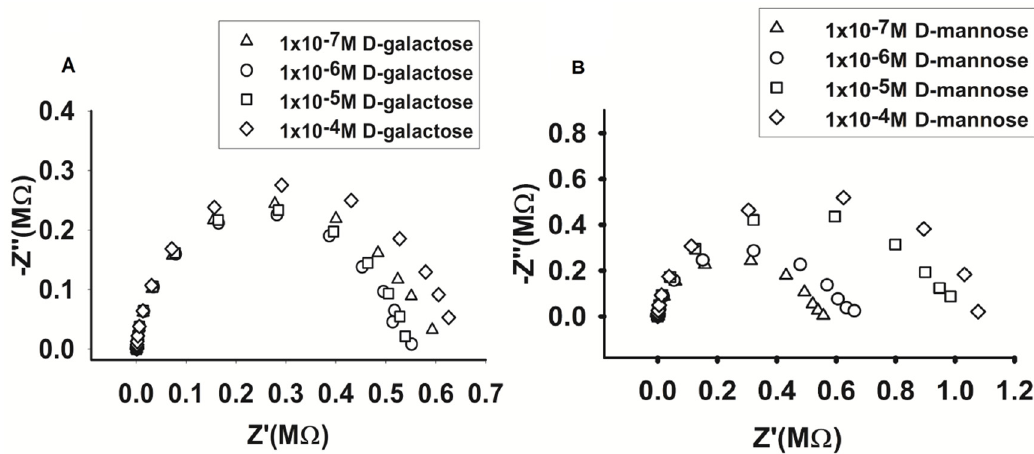
Figure 3. Nyquist plots of ( A ) D-mannose ( B ) D-galactose, both in a concentration of 10 − 7 –10 − 4